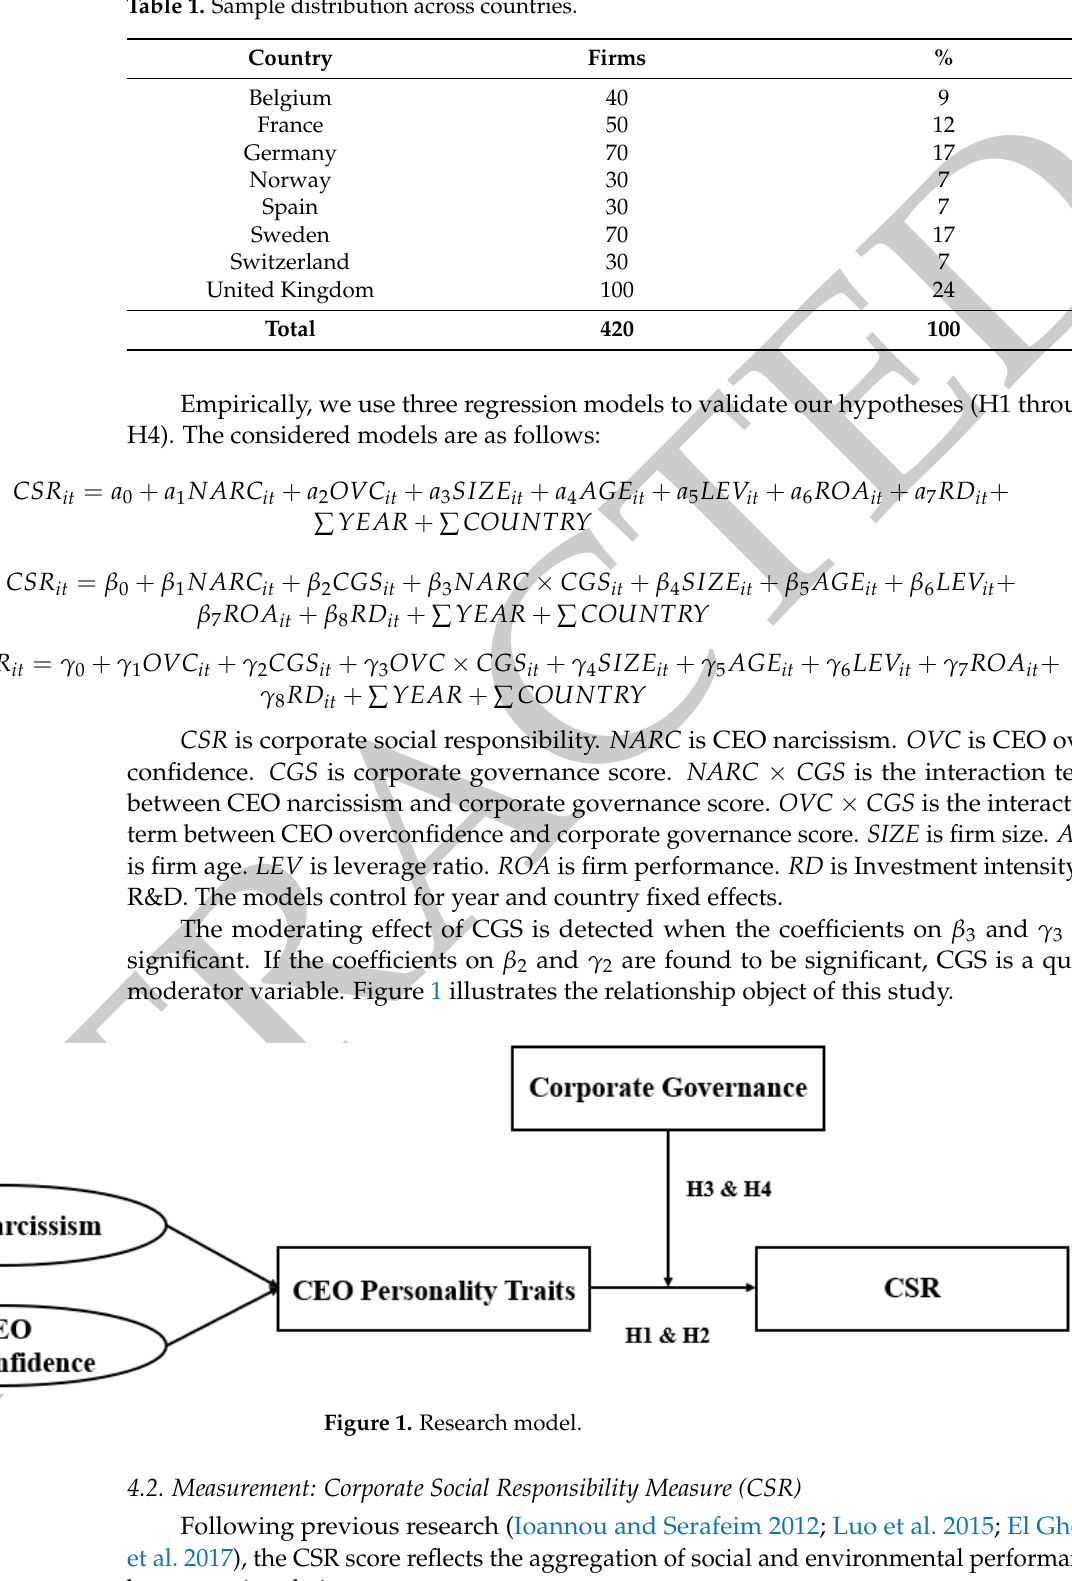
Table 1. Sample distribution across countries.